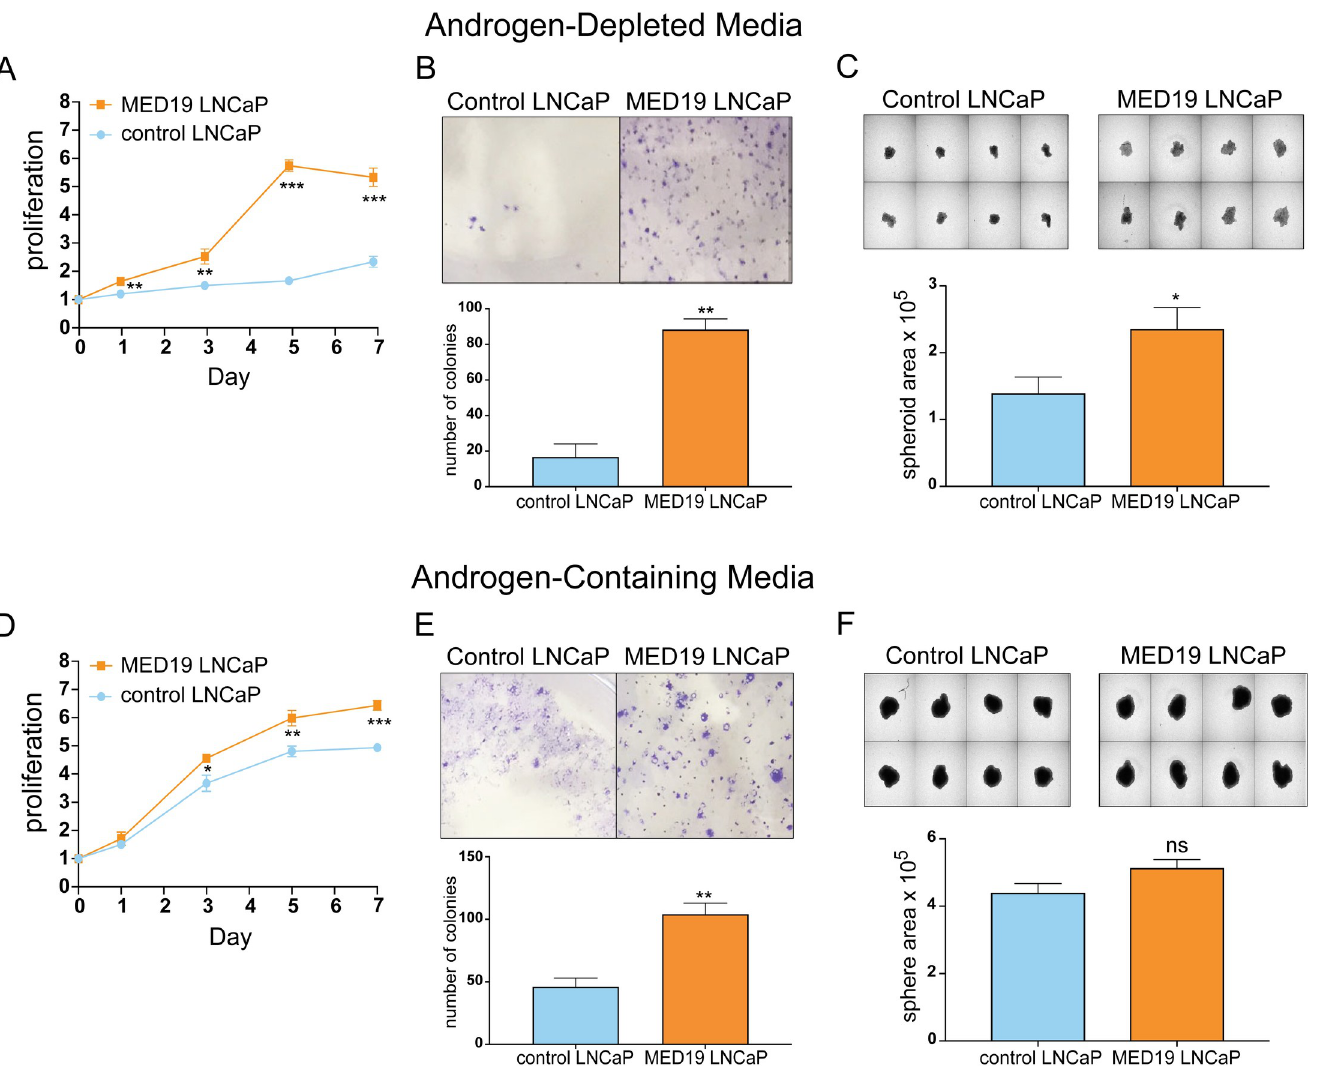
Fig 1. MED19 overexpression confers a growth advantage and enables androgen-independent growth of LNCaP cells. LNCaP cells stably overexpressing MED19 (MED19 LNCaP cells) and LNCaP cells expressing the empty lentiviral vector (control LNCaP cells) were cultured in media depleted of androgens by addition of FBS charcoal-stripped of steroids (A, B, C) or media containing androgens by addition of standard FBS (D, E, F). A) and D) Proliferation was measured over 7 days and is expressed as fold change in relative fluorescent units (RFU), normalized to Day 0. B) and E) Colony formation was evaluated by culturing MED19 LNCaP cells and control LNCaP cells at low density for 11 days, fixing and staining with crystal violet, and quantifying the number of colonies per field (n = 3). C) and F) Spheroid formation was evaluated by culturing cells on low attachment plates for 10 days and quantifying average spheroid area. Experiments were performed in biological triplicate, with representative results shown. � p < 0.05; �� p < 0.01; and ��� p < 0.001. ns = not